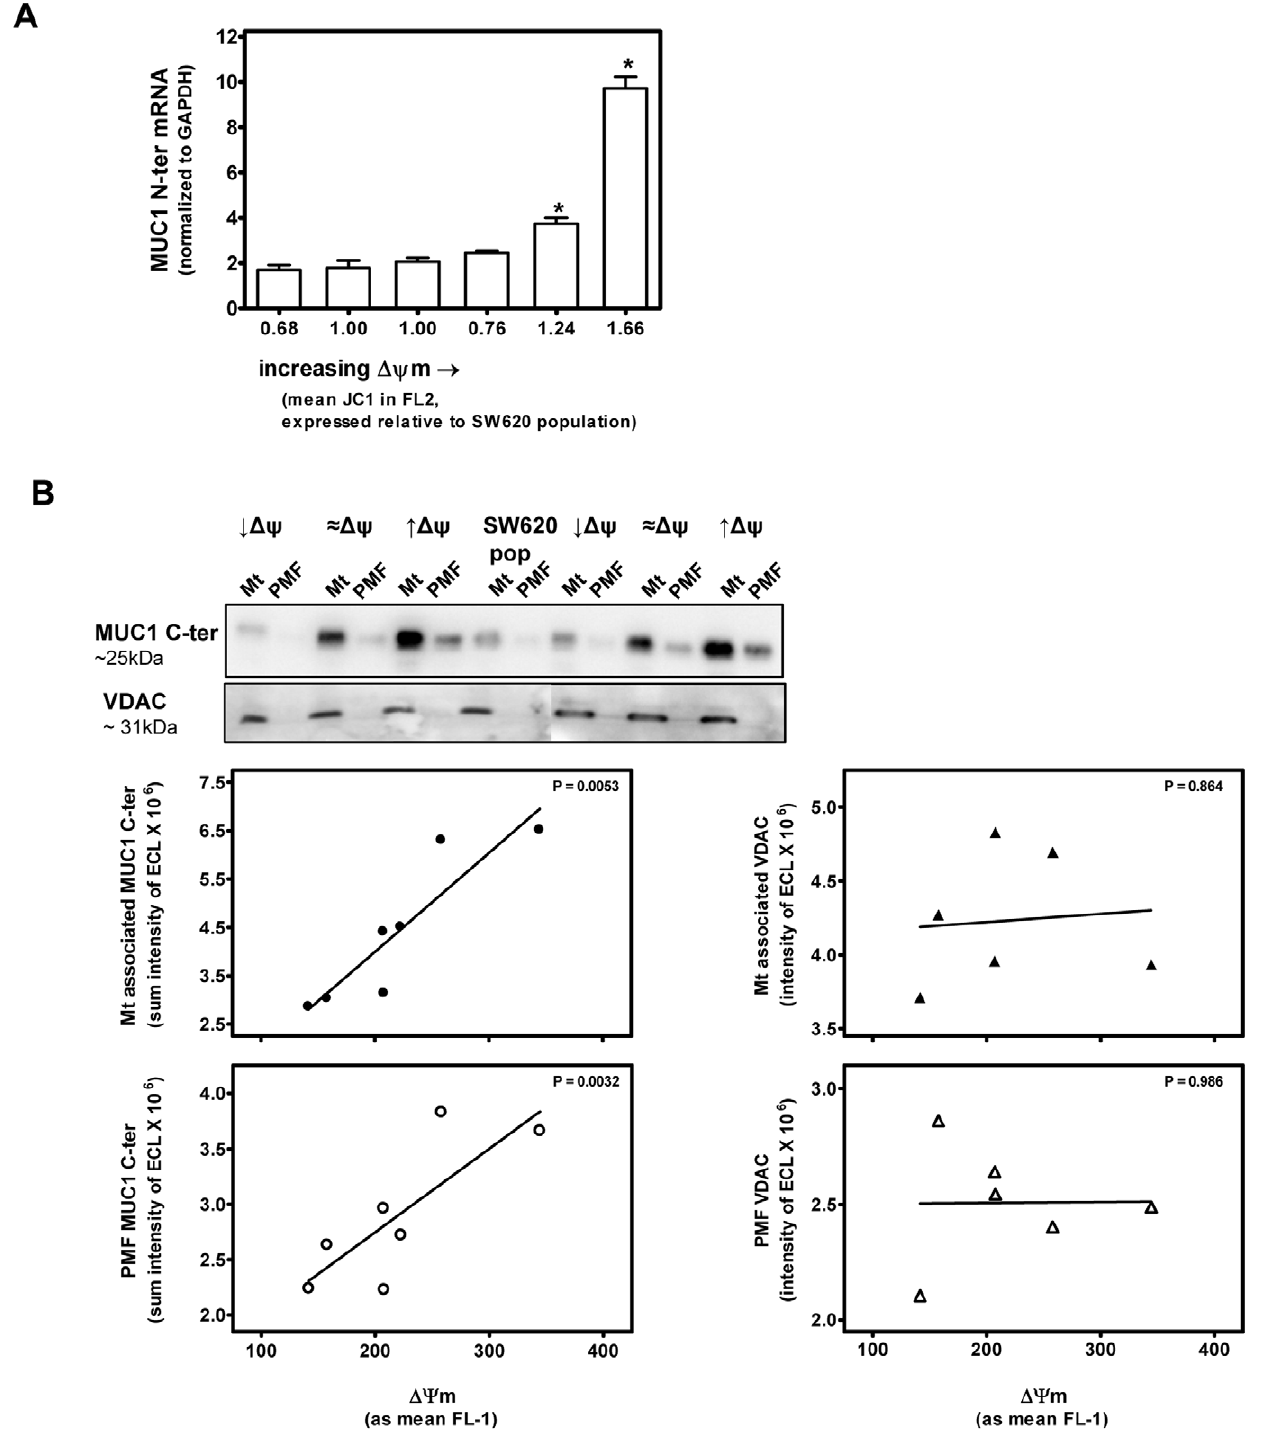
Figure 1. Constitutive MUC1 levels are associated with stable differences in intrinsic Dy m of subcloned cell lines derived from SW620 colonic carcinoma cell population. A: Steady state mRNA levels of MUC1 were determined by qRT-PCR, normalized to GAPDH, in the parental population of SW620 cells and in subcloned cell lines derived from SW620 cells that have a range stable intrinsic Dy m. (*; P , 0.001 vs. the population of SW620 cells.) B: Immunoblots of mt and PMF from the SW620 colonic carcinoma cell population and from subcloned lines derived from SW620 cells with intrinsic Dy m higher ( q Dy m), lower ( Q Dy m) and comparable ( < Dy m) to that of the population were probed with anti-MUC1 C- ter and anti-VDAC and chemiluminescence signals quantified and expressed as a function of the intrinsic Dy m, determined by JC-1 staining, using linear regression analyses. MUC1 C-ter, but not VDAC, levels in both mt enriched and PMF are significantly associated with the intrinsic Dy m ( P =0.0053 and 0.0032, respectively).